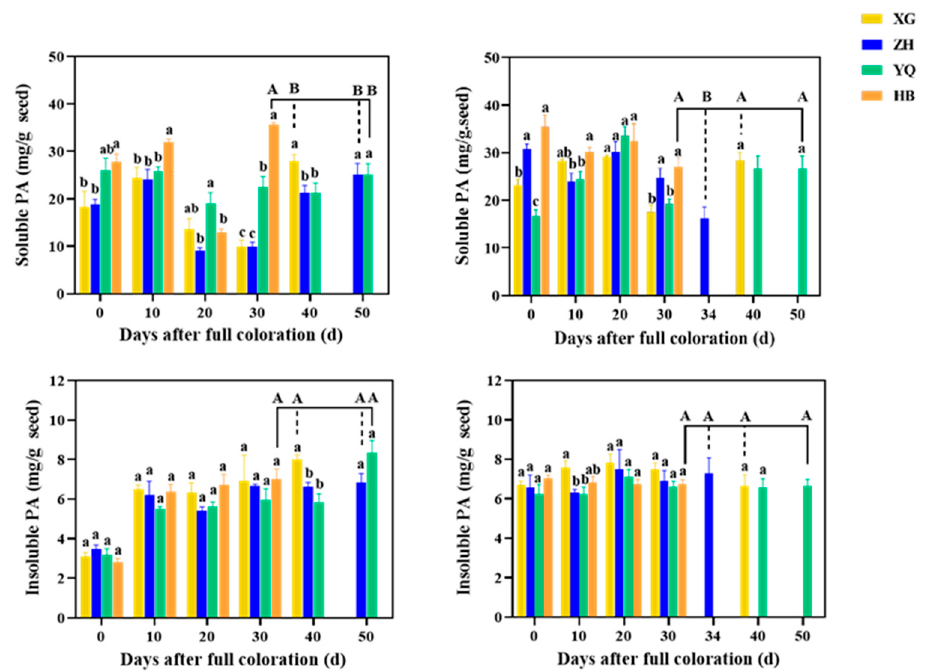
Figure 4. PA content of four different sub-regions of ‘Cabernet sauvignon’ ( left ) and ‘Marselan’ ( right ). Explanation about the lowercase and uppercase letters is the same as that in Figure 2.